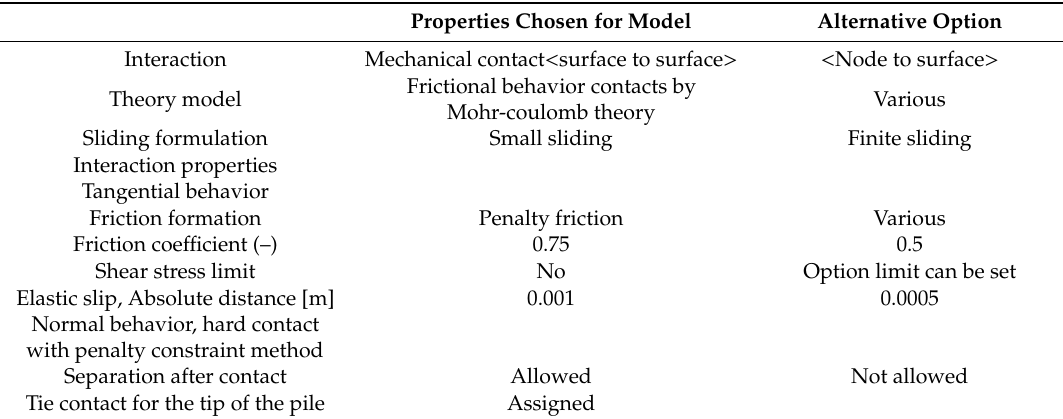
Figure 5. Soil-pile interface modeling in Abaqus ™ ( a ) No sliding, ( b ) Sliding. Table 4. Interaction parameters.